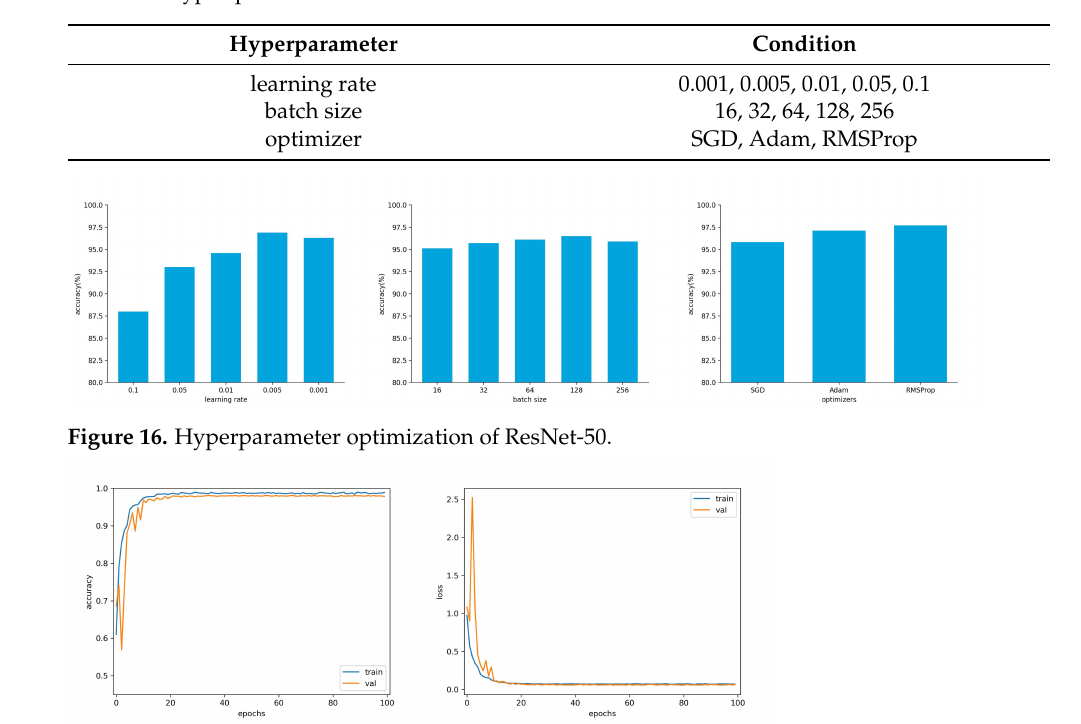
Table 13. Hyper-parameter details of ResNet-50.